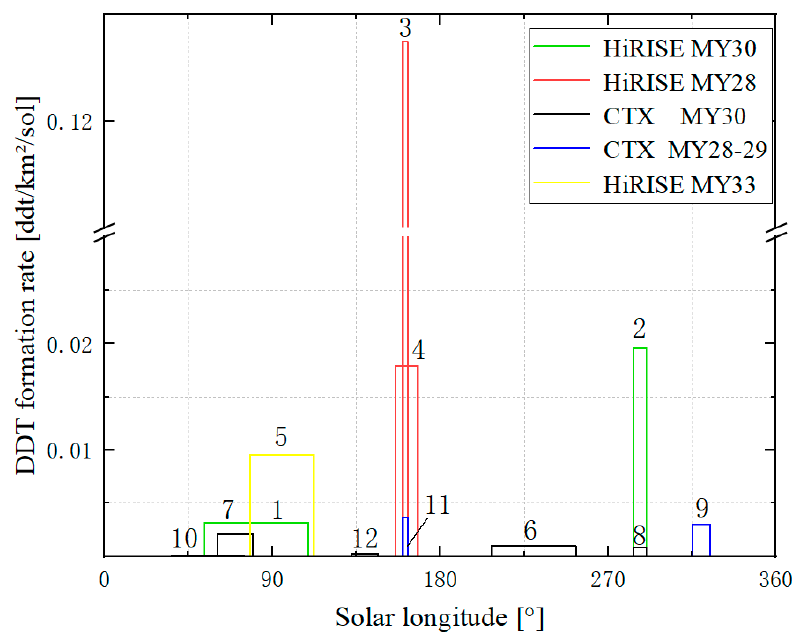
Figure 7. DDT formation rates of 12 image pairs in the study area. Green rectangle represents DDT formation rates of HiRISE images in MY30, red rectangle represents DDT formation rates of HiRISE images in MY28, black rectangle represents DDT formation rates of CTX images in MY30, blue rectangle represents DDT formation rates of CTX images in MY28–29, and yellow rectangle represents DDT formation rates of CTX images in MY33.